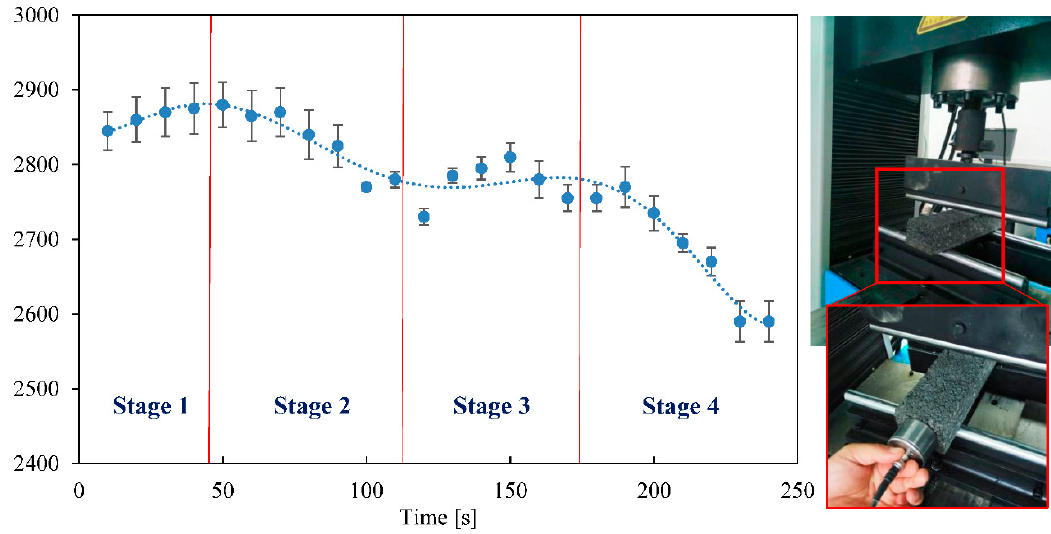
Figure 6. The change trend of ultrasonic velocity during the whole process of damage.